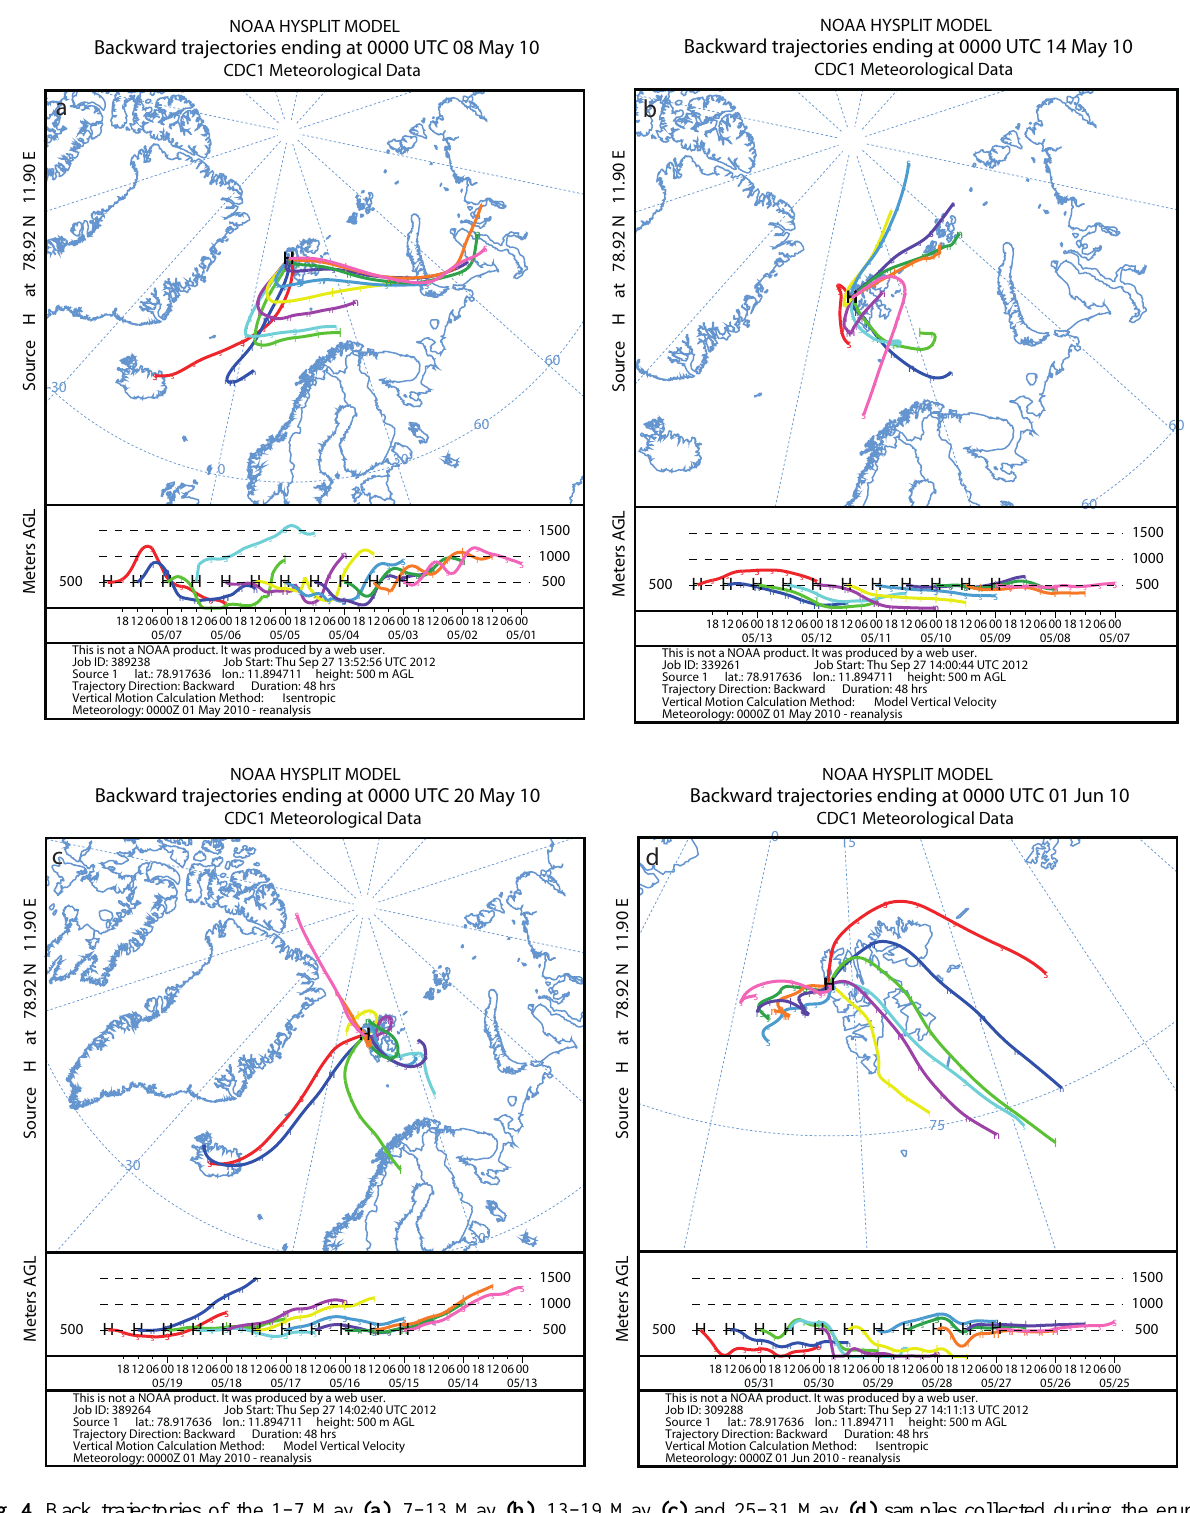
Fig. 4. Back trajectories of the 1–7 May (a) , 7–13 May (b) , 13–19 May (c) and 25–31 May (d) samples collected during the eruption of the Eyjafjallaj¨okull volcano. The 48h back trajectories are calculated at 500m for the entire sampling period, starting a new trajec- tory every 12 hours, with the NOAA HYSPLIT trajectory model from the NOAA ARL website (http://www.arl.noaa.gov/ready/). We used the NCEP/NCAR Reanalysis meteorological database and the isentropic trajectories as they incorporate vertical transport components and integrate the vertical difference between the HYSPLIT model and the NCAR reanalysis